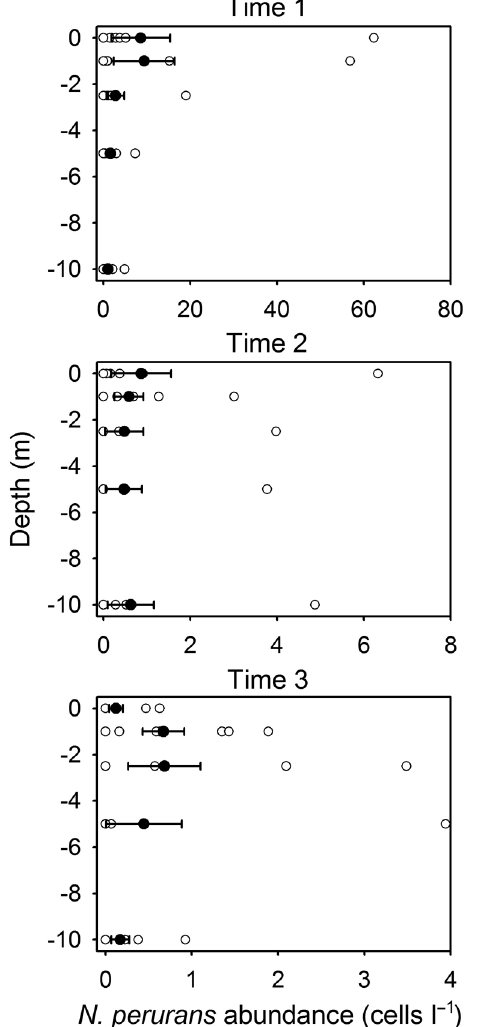
Fig. 3. Individual data points (open circles) overlaid with means ± SE (solid circles) of abundance of free-living Neo - para moeba perurans plotted against depth for each time. Note the different x -axis scales among times for abun- dance